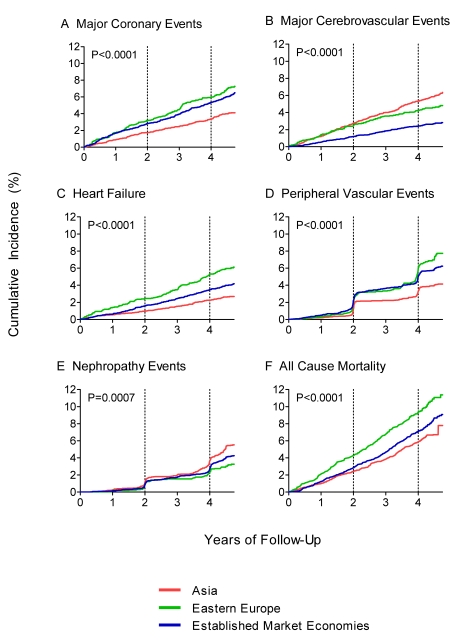
Cumulative incidence of major complications and all-cause mortality in the ADVANCE study, by region.(A–E) Major complications. (F) All-cause mortality.